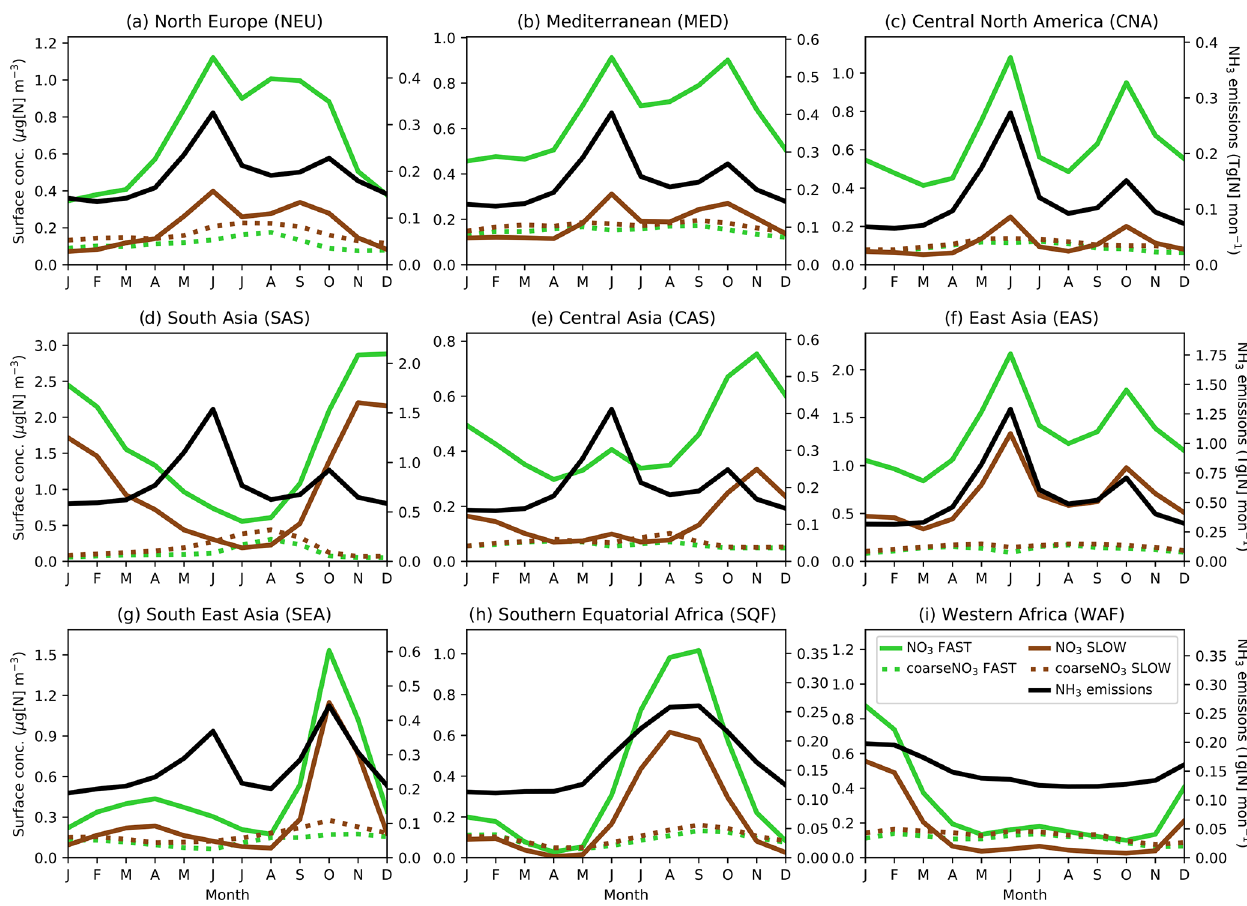
Figure 4. Regional and monthly-mean NO 3 (solid line) and coarseNO 3 (dashed line) near-surface concentrations and NH 3 emissions (solid black line) time series for the SLOW (brown) and FAST (green) simulations for nine Giorgi regions (Giorgi, 2006) (land-only), representing areas with high NO 3